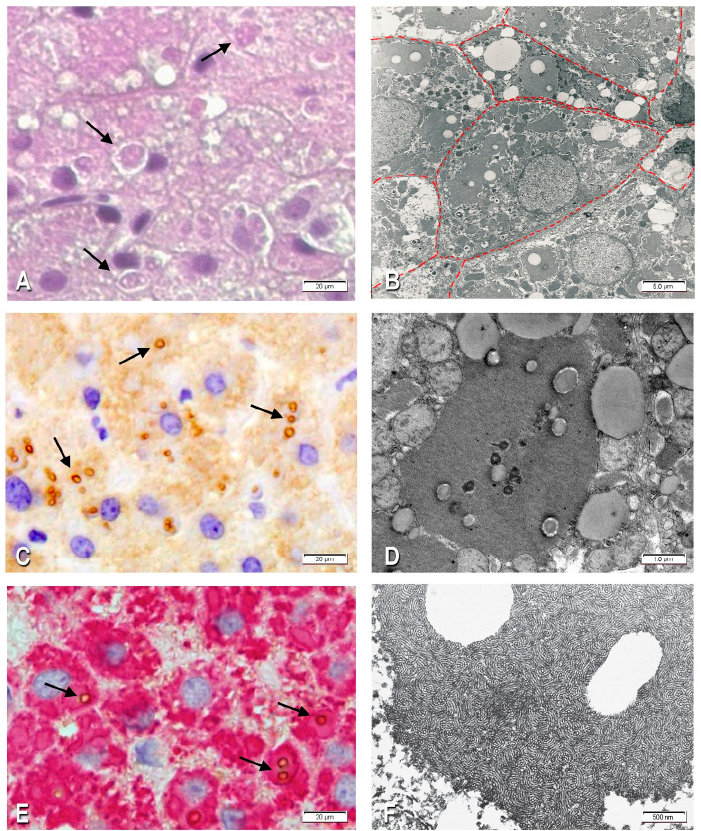
Figure 1. Liver tissue sections from the proband Aguadilla case ( A ) Hematoxilin and Eosin (HE) 100×; the microphotograph shows hepatocytes with plenty of round eosinophilic cytoplasmic inclusions surrounded by a clear halo. Individual inclusions contain empty vacuoles that can be single or multiple (arrows); ( B ) EM 2500×; the electronmicrophotograph from the same case shows four hepatocytes with dilated cisternae of the ER filled up with tubular curved bundles corresponding to fibrinogen. Lipid droplets are present within the fibrinogen. The cytosol contains lipid inclusions of variable size (microsteatosis). A color line draws the hepatocytes shapes; ( C ) Immunostaining of a serial section from the same case stained with an anti-APOB antibody, 100×, showing positivity in the form of single or multiple inclusions. Positivity is strong in the periphery of the droplets (arrows), whilst the central core remains negative; ( D ) EM 12,000×; a large dilated cisterna of ER containing fingerprint-like tubular structures filling up the entire lumen. A few small lipid droplets are located within the tubular structures; ( E ) Double immunostaining of a serial section from the same case, using an anti-fibrinogen and an anti-APOB antibodies sequentially (1000×). Fibrinogen inclusions fill up the entire hepatocyte cytoplasm and are stained in red; the lipid droplets containing APOB are stained in dark brown. The latter can be single or multiple, and the positivity is located at the periphery of the droplets (arrows); ( F ) EM 18,000×; fibrinogen Brescia case. The electronmicrophotograph shows a high magnification of a dilated cisterna of ER filled up with fingerprint-like tubular structures arranged in curved bundles. The fibrinogen inclusion contains two large lipid droplets.